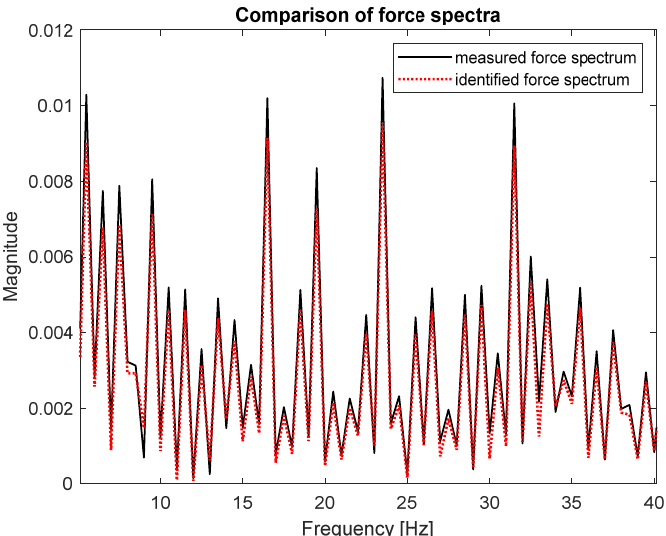
Figure 10. Comparison of measured and identified force spectra—zoomed frequency range (modal filter method).